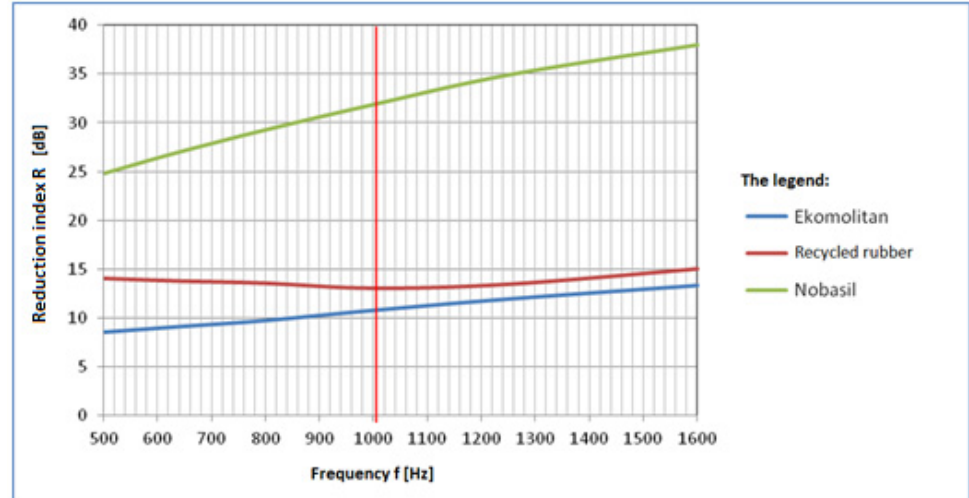
Figure 11. Reduction index R (material thickness—60 mm).